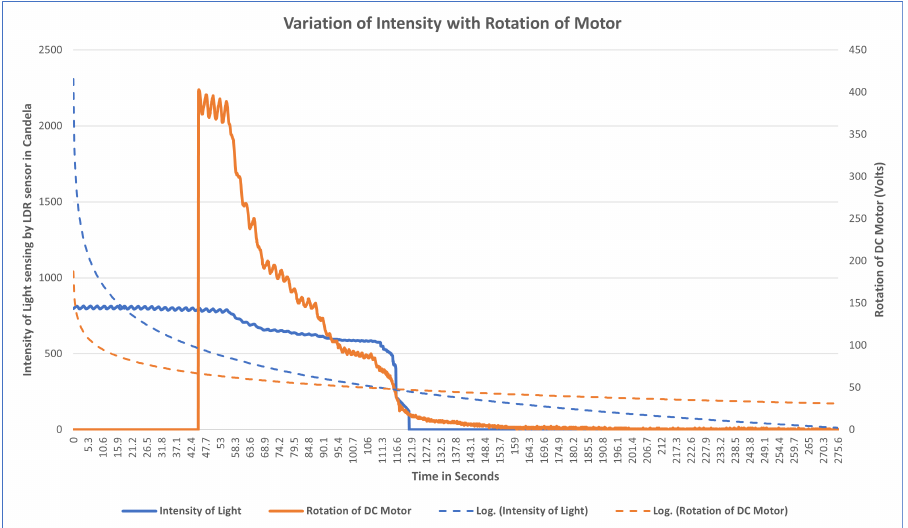
Figure 17. Variation of rotation of motor with the average intensity of light of upper LDR